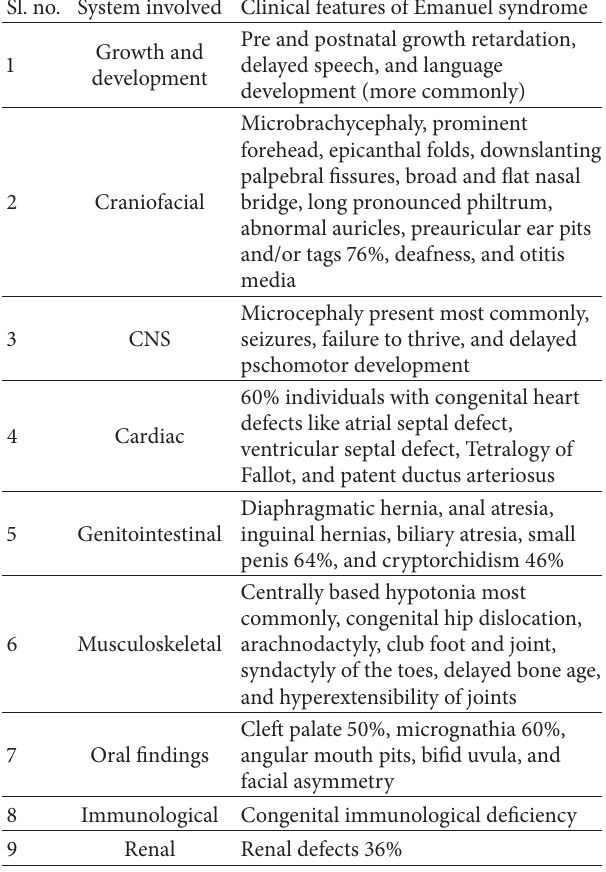
Table 1: List of reported cases of Emanuel syndrome [6–13]. Sl. no.